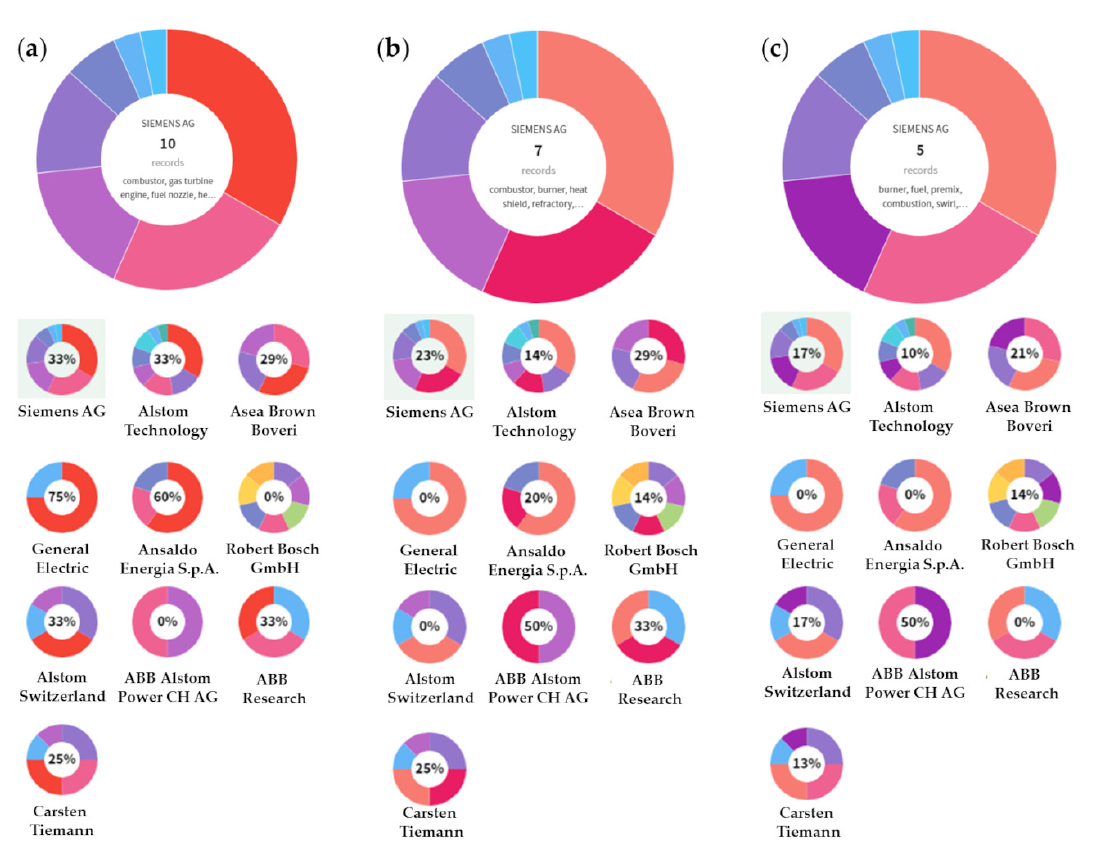
Figure 4. Analysis of the three main technological areas related to the inventions. Comparisons between the top filing company, Siemens AG, and other companies, wherein ( a , red) refers to combustor, gas turbine engine, fuel nozzle, heat shield, cooling hole, turbofan, and impingement; ( b , pink) refers to gas turbine engine, combustor, turbocharger, compressor, turbomachine, bleed, and spool; and ( c , purple) refers to burner, combustion, fuel, gas, flue, fluidized bed reactor, and coal. In the center of the larger donut chart is the number of patent documents of the main applicant for a given technology and, in the smaller donut charts, the percentage of companies involved in the production of inventions related to this technology.